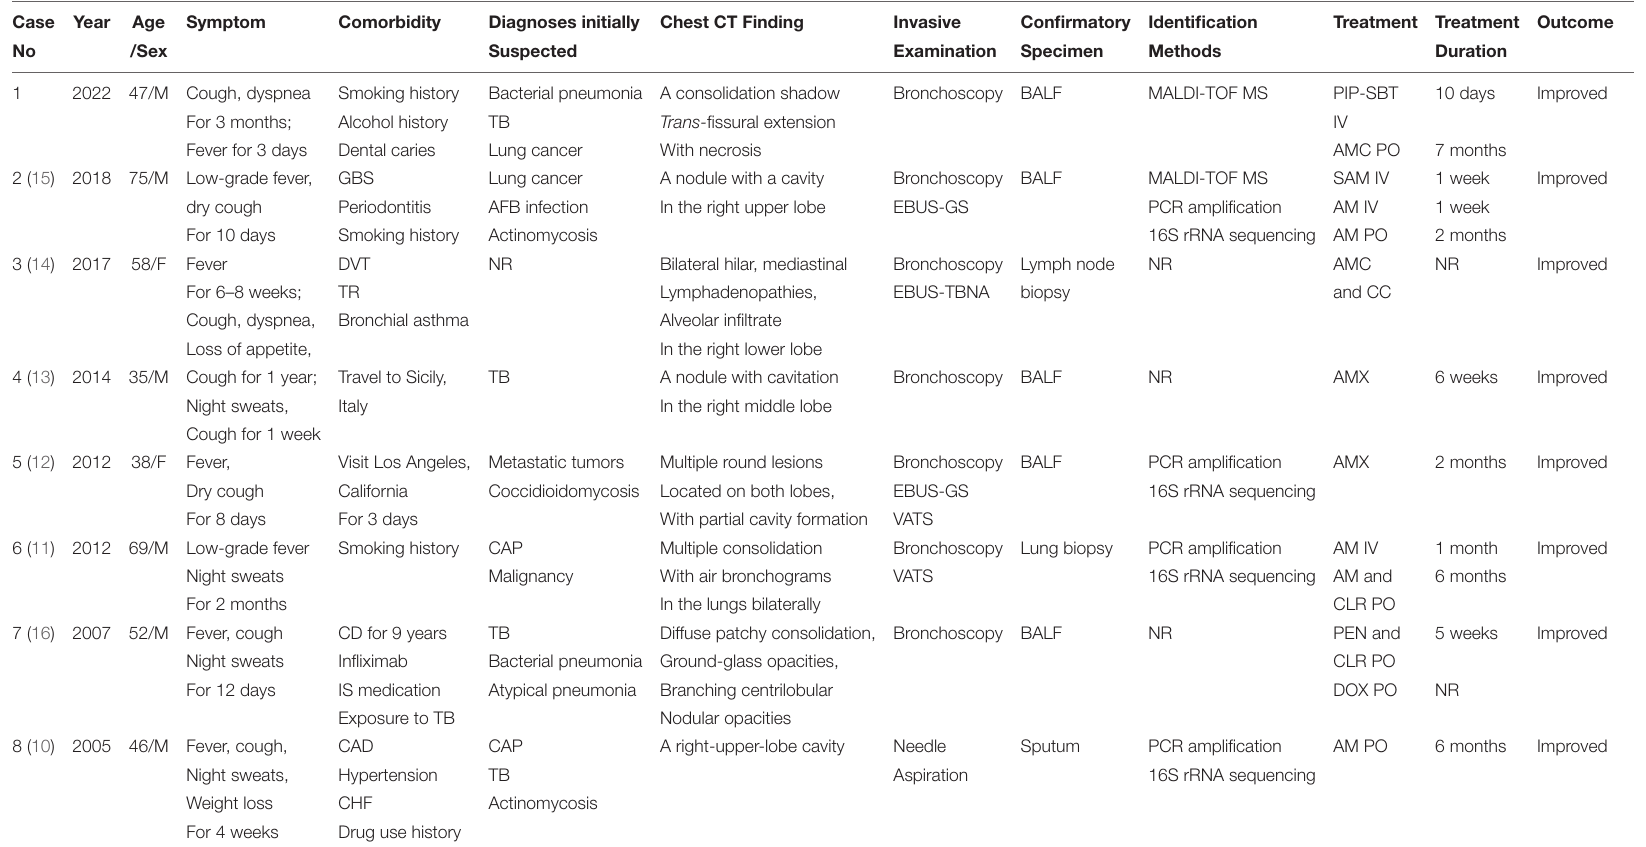
TABLE 1 | The characteristics of the eight cases of pulmonary Actinomyces graevenitzii infection. Case Year Age